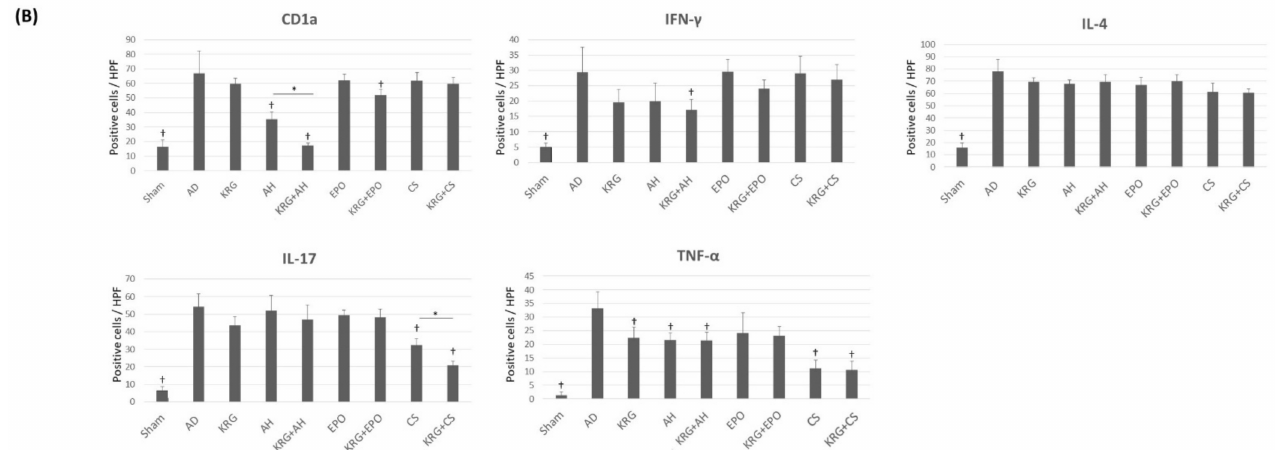
Figure 3. The expression profiles of various cytokines after administering KRG and conventional systemic therapeutics of AD in TNCB-induced AD mouse model ( A ) The representative images of immunohistochemical stainings of skin lesions in each group (CD1a, 400x; IFN- γ , 400x; TNF- α , 400x; IL-17, 400x; IL-4, 400x). Scale bar, 20 µ m. ( B ) The bar graphs illustrate the quantification of CD1a, IFN- γ , TNF- α , IL-17, and IL-4 expressions in each group. † indicates p < 0.05 compared to the AD group. * indicates p < 0.05 in AH versus KRG + AH, CS versus KRG + CS, EPO versus KRG + EPO, respectively. All the data were presented as the mean and the standard error of the mean. Abbreviation: AD, atopic dermatitis; AH, antihistamine; CS, cyclosporine; EPO, evening primrose oil; KRG, Korean Red